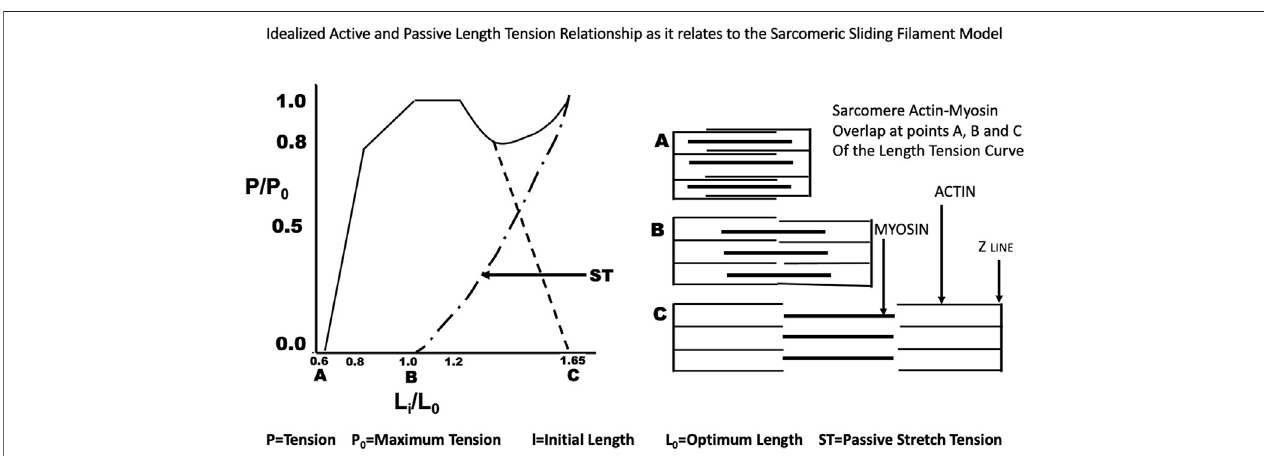
FIGURE2| TheidealizedLengthTensioncurveasitrelatestotheoverlapofactinandmyosininthesarcomereasdescribedbyGordon,HuxleyandJulian(Gordon et al., 1966).